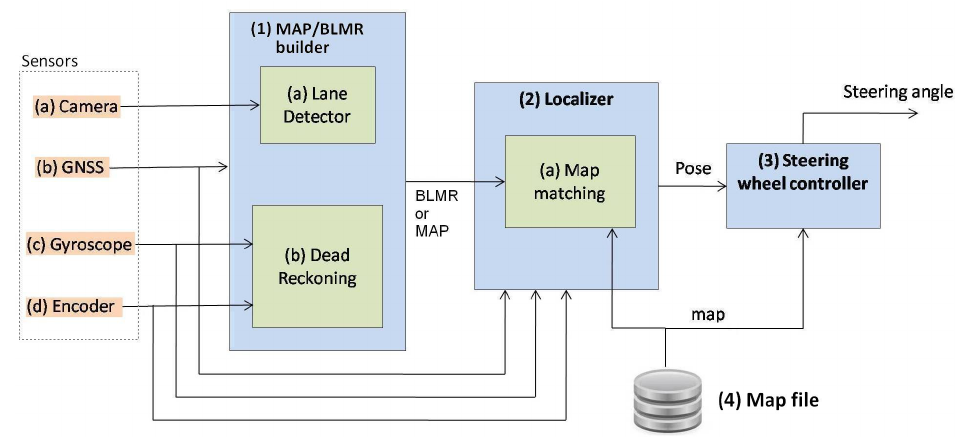
Figure 2. The software architecture for mapping (only Module 1) and autonomous driving (all